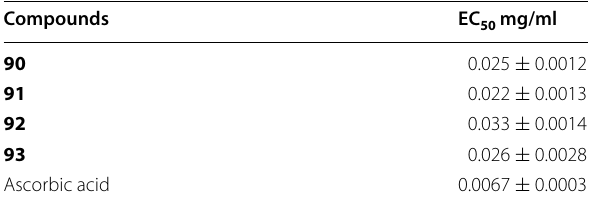
there is a need for new drugs targeting enzymes essential to mycobacterium survival [41, 42].